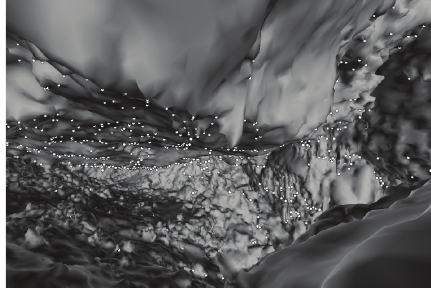
Figure 3: Web visualization of the cave chamber 3D mesh model with 249 934 triangles and local minima (stalactites extremities) as white points.